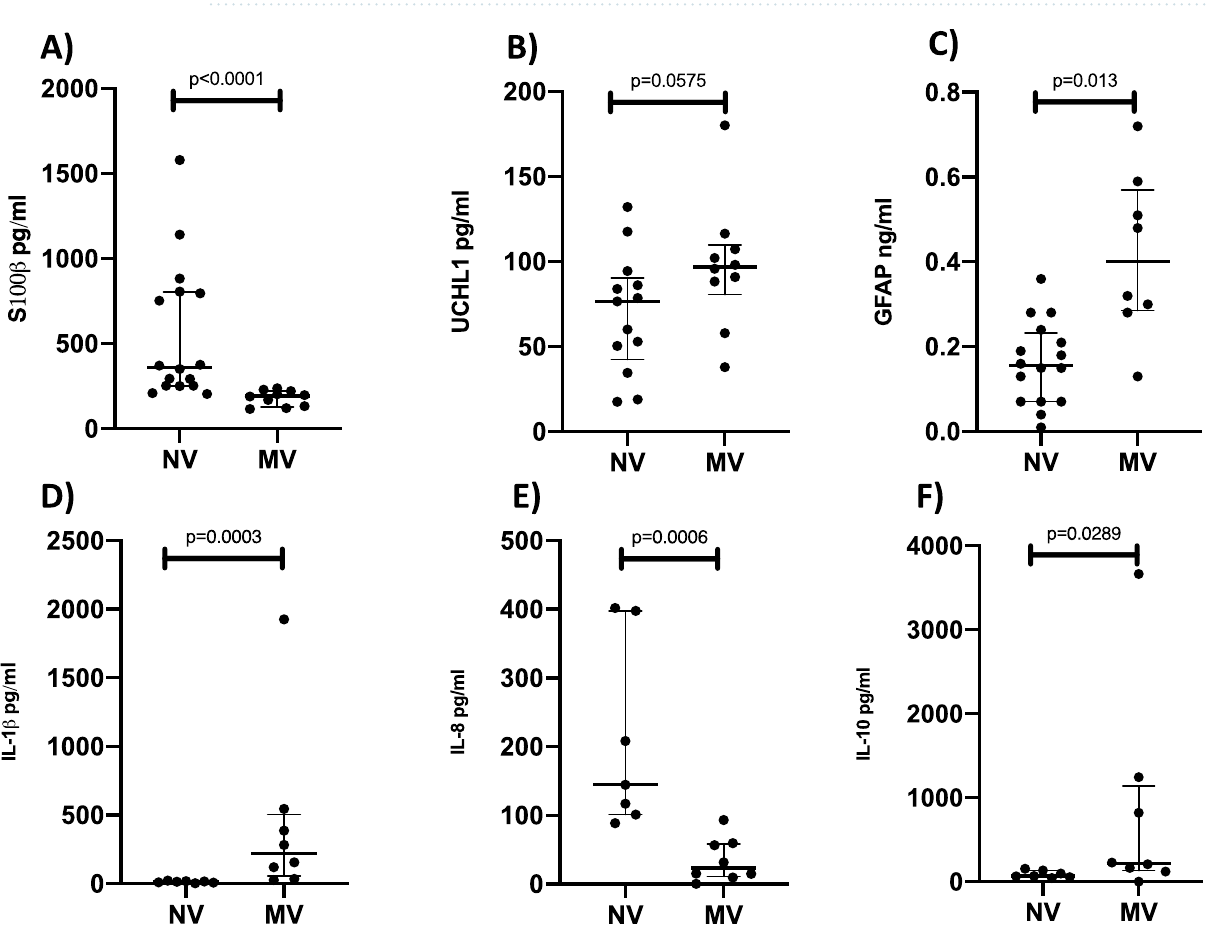
Figure 6. ( A ) Dot plot showing serum concentrations of S100β, 360.90 pg/ml (252.10–803.60) in the NV group and 193.10 pg/ml (129.20–223.30) in the MV group, p < 0.0001 (n = 10–16 per group). ( B ) Dot plot showing serum concentrations of UCHL1, 76.57 pg/ml (42.48–90.26) in the NV group and 96.96 ng/ml (80.65–109.60) in the MV group, p = 0.0575 (n = 10–13 per group). ( C ) Dot plot showing serum concentrations of GFAP, 0.15 ng/ml (0.07–0.23) in the NV group and 0.40 ng/ml (0.28–0.57) in the MV group, p = 0.0013 (n = 8–16 per group). ( D ) Dot plot showing serum concentrations of IL-1β, 13.39 pg/ml (7.72–17.68) in the NV group and 219.60 pg/ml (56.23–505.40) in the MV group, p = 0.0003 (n = 7–8 per group). ( E ) Dot plot showing serum concentrations of IL-8, 144.50 pg/ml (100.90–397.90) in the NV group and 23.40 pg/ml (10.88–58.51) in the MV group, p = 0.0006 (n = 7–8 per group). ( F ) Dot plot showing serum concentrations of IL-10, 67.92 pg/ml (55.60–134.80) in the NV group and 217.50 pg/ml (131.30–1,140.00) in the MV group, p = 0.0289 (n = 7–8 per